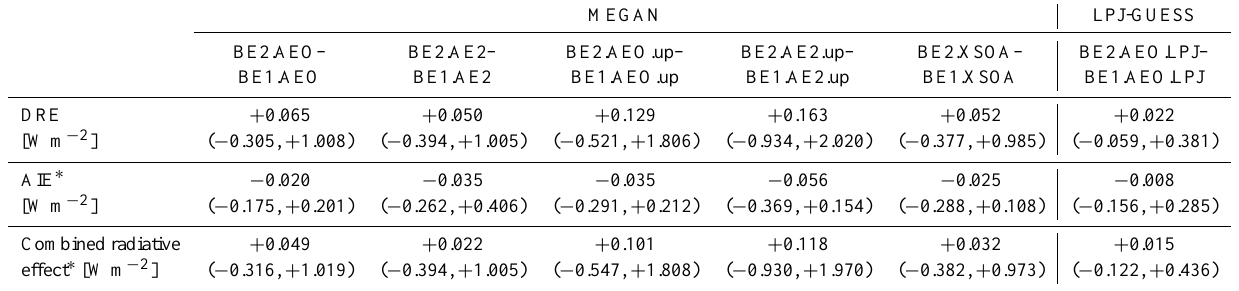
Table 3. Summary of global, annual mean changes in aerosol direct radiative effect (DRE), first aerosol indirect effect (AIE), and combined radiative effect in Wm − 2 when changing BVOC emissions from year 1000 to year 2000 using the MEGAN and LPJ-GUESS reconstructions. The values in brackets are the global maximum and minimum changes, respectively.